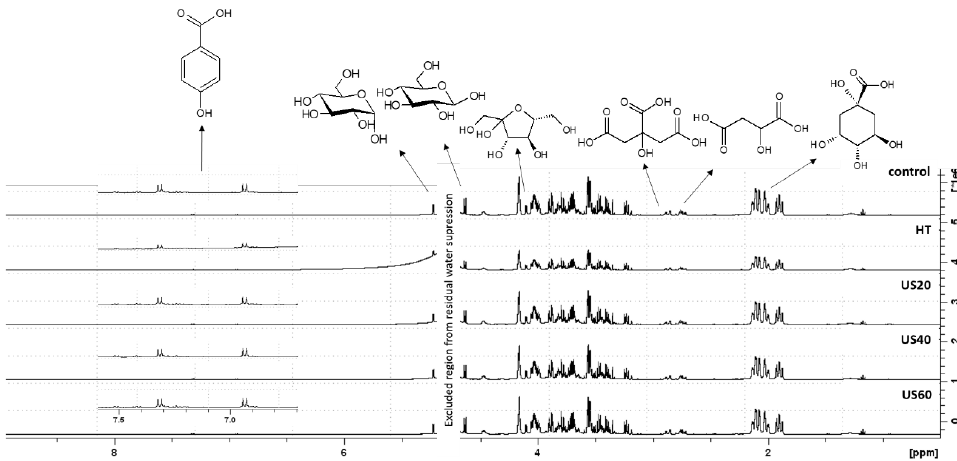
Figure 1. 1 H NMR spectrum (H 2 O:D 2 O, 500 MHz) of the treated juices submitted and amplification of the aromatic region (6.7 to 7.6